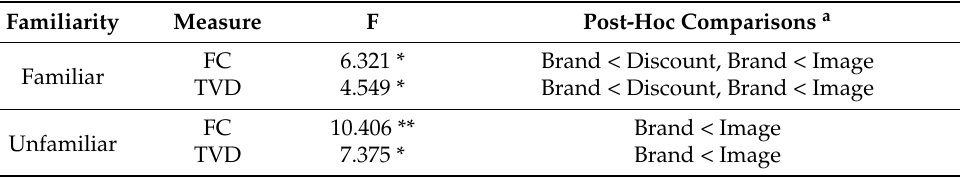
Table 3. ANOVA results demonstrating the influence of brand familiarity on visual